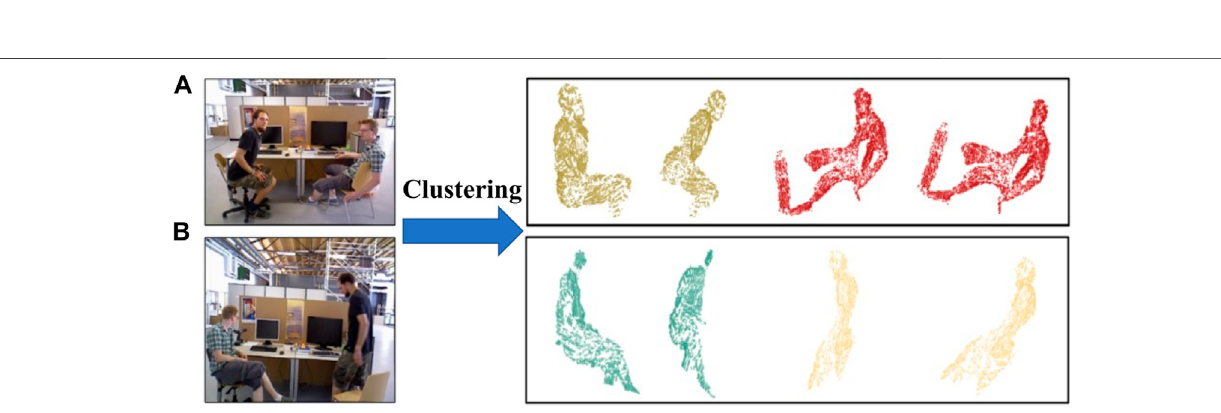
FIGURE 6 | The illustration of dense point cloud reconstruction thread in OC-SLAM system which is designed to perform the construction and clustering of dense point clouds without moving objects.